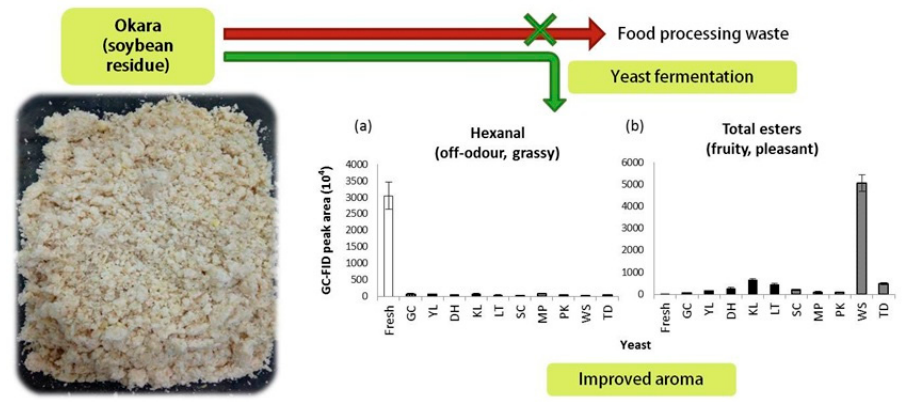
Figure 8. Changes in ( a ) hexanal and ( b ) total esters in fresh and yeast-fermented okara (GC = G. candidum , YL = Y. lipolytica , DH = D. hansenii , KL = K. lactis , LT = L. thermotolerans , SC = S. cerevisiae , MP = M. pulcherrima , PK = P. kluyveri , WS = W. saturnus , TD = T. delbrueckii ) (Image credit: VONG